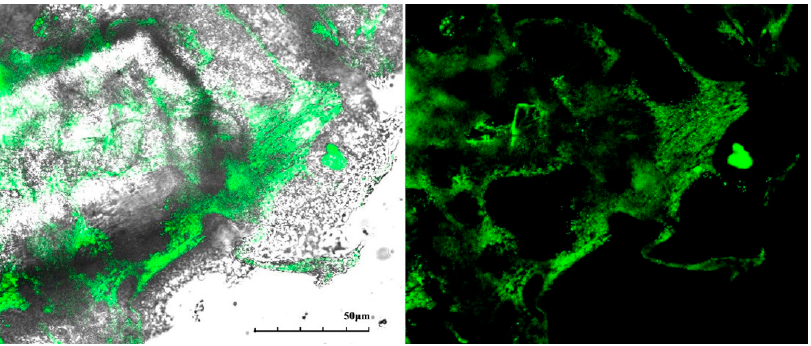
Figure 5. Confocal laser scanning microscopy (CLSM) images of the immobilized BCL labeled with FITC (showing a green signal).